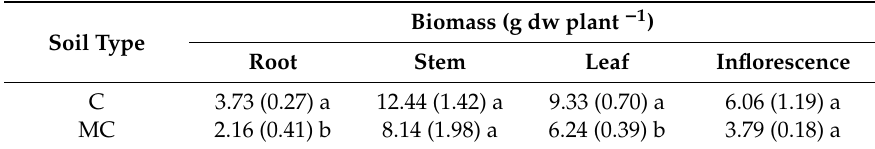
Table 3. Dry biomass of di ff erent organs of hemp plants ( Cannabis sativa L., cv. Codimono) obtained after 90 days of growth in a greenhouse in pots filled with soil sampled in two di ff erent sites (C and MC) in the “Valle del Sacco” area (Lazio Region, Central Italy). In each column, mean values (n = 4 ± SE) are reported. Di ff erent letters indicate significantly di ff erent values (t-test, p ≤